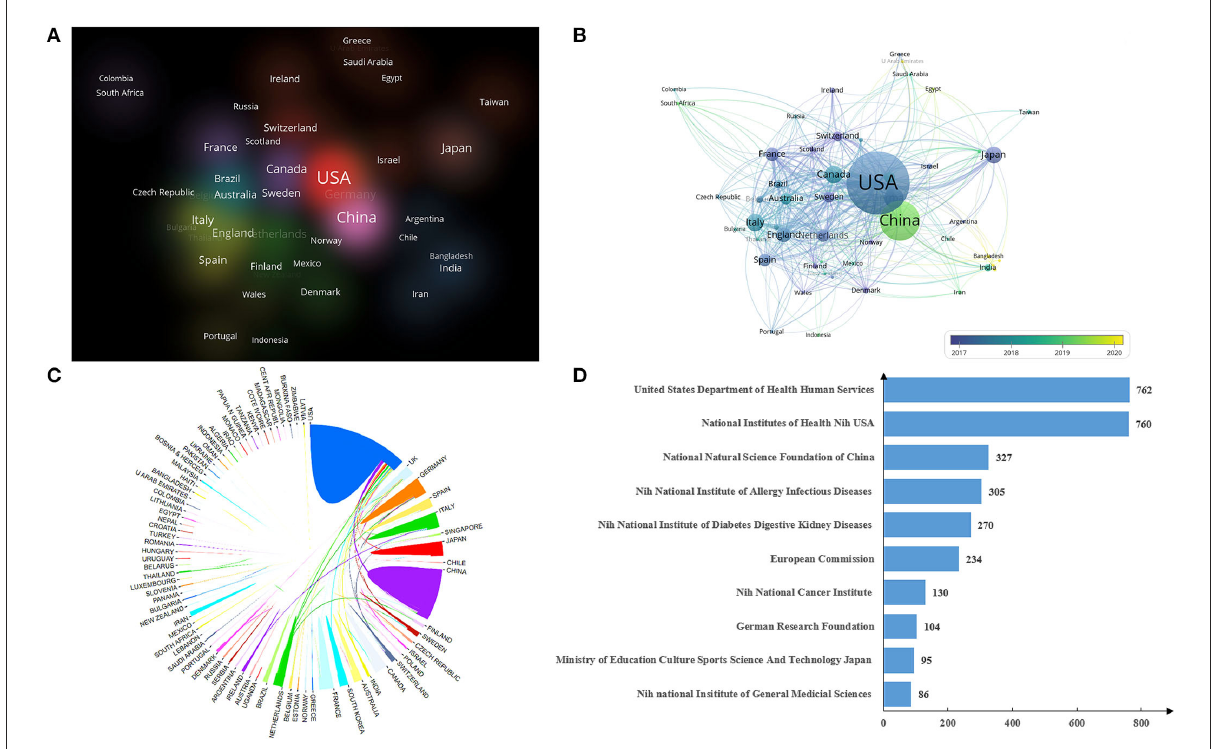
FIGURE4 Cooperation network of countries/regions with regard to research gut microbiota and host immune response. (A,B) Network of cooperative relations between countries/regions established by VOSviewer. (C) Visualized cooperative relations between countries/regions. (D) Top 10 funding